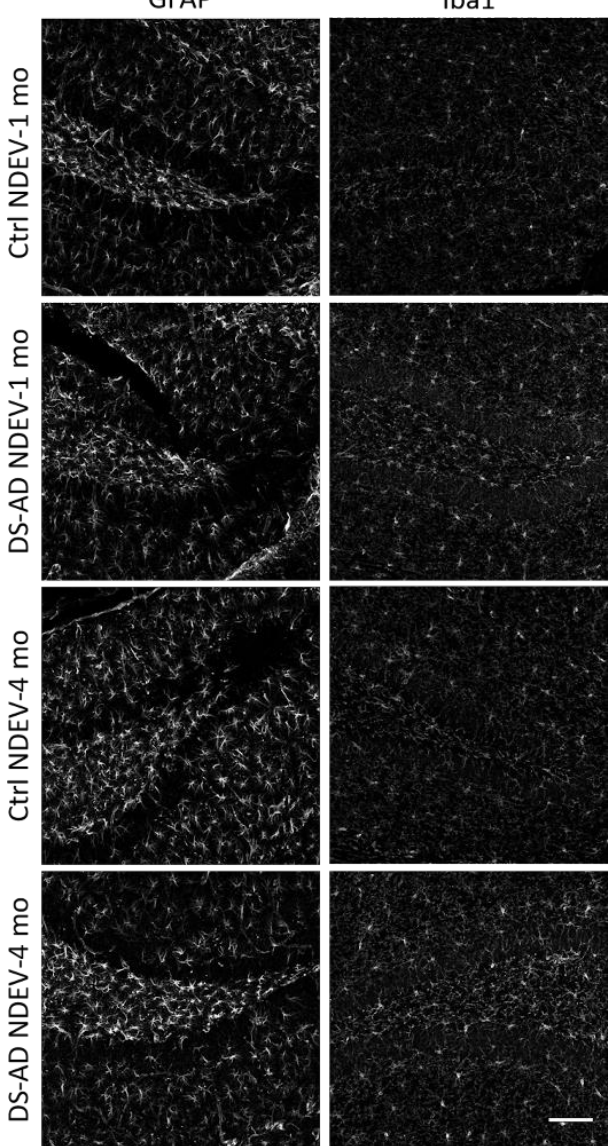
Figure 7. Representative images for GFAP (on the left) and Iba1 (on the right) immunofluorescent staining. Note an increase in staining intensities in mice who received DS-AD NDEVs compared to control NDEV injections. The astrogliosis following DS-AD NDEVs was more obvious but also displayed more variability between animals 4 months following the injections. Note an increase in Iba1 staining intensity in DS-AD NDEV-injected mice 4 months following injection, and to a lesser extent 1 month following injection. Scale bar represents 100